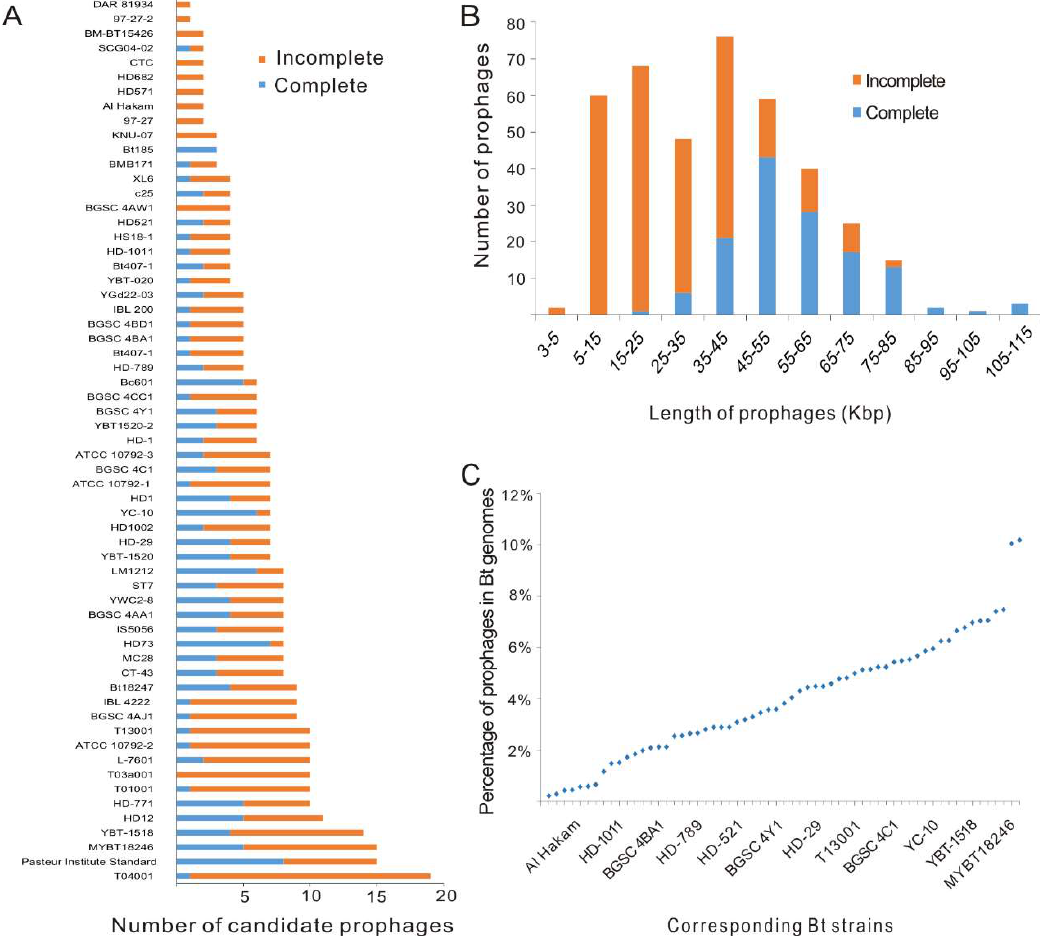
Figure 1. Characterization of candidate prophage regions identified in 61 Bt genomes. ( A ) The number of candidate prophage regions in each genome. ( B ) Sequence length distribution of all 398 candidate prophage regions identified in Bt genomes. ( C ) The percentage of the total genome size of all prophage regions from the same Bt genome in the corresponding strain.